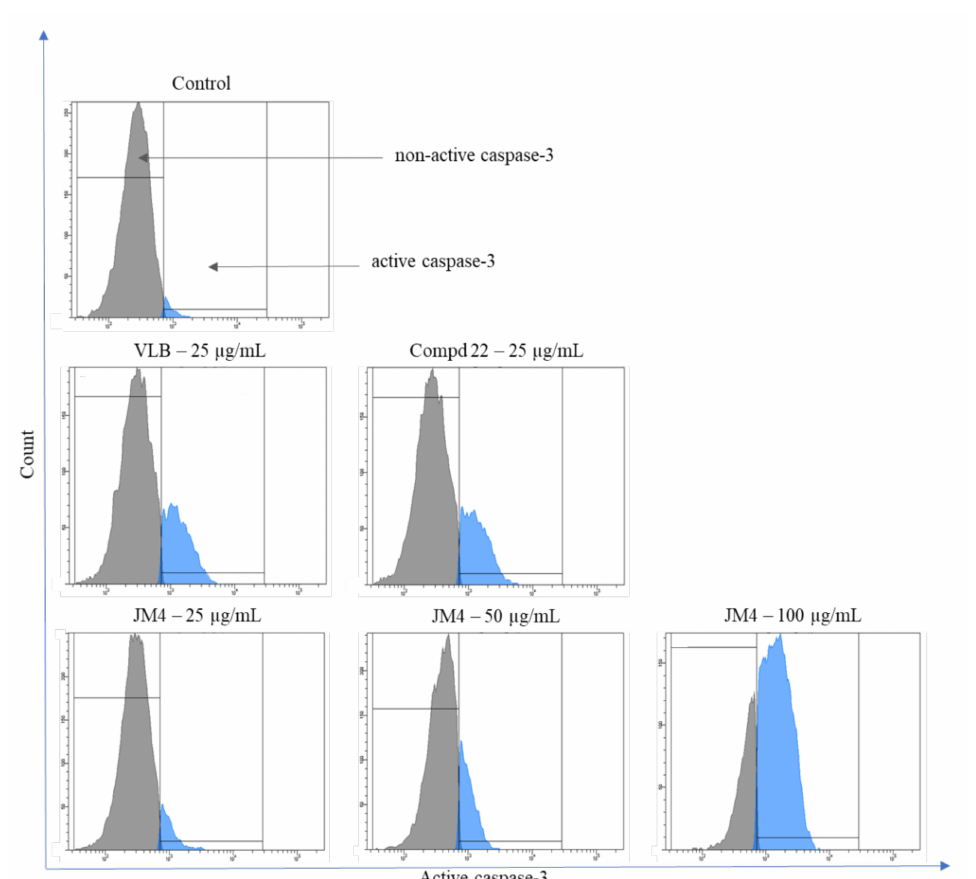
Figure 11. Flow cytometric analysis of populations C32 melanoma cells treated for 24 h with JM4 (25, 50, 100 µ g/mL), 22 (25 µ g/mL) and vinblastine sulfate (VLB) (25 µ g/mL) for active caspase-3.